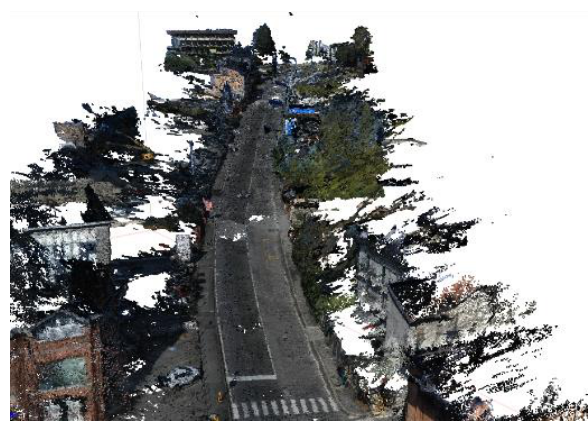
Figure 6. The reference dense cloud point of Via Sant’Eufemia